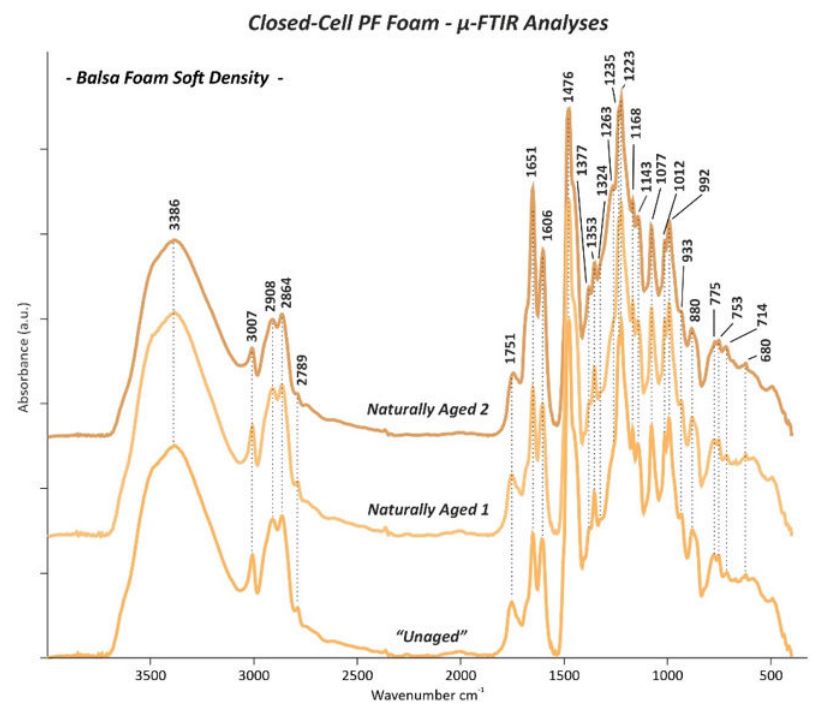
Figure 11. µ -FTIR spectra of the “Unaged” and Naturally Aged 1 and 2 Balsa foam soft density closed-cell PF